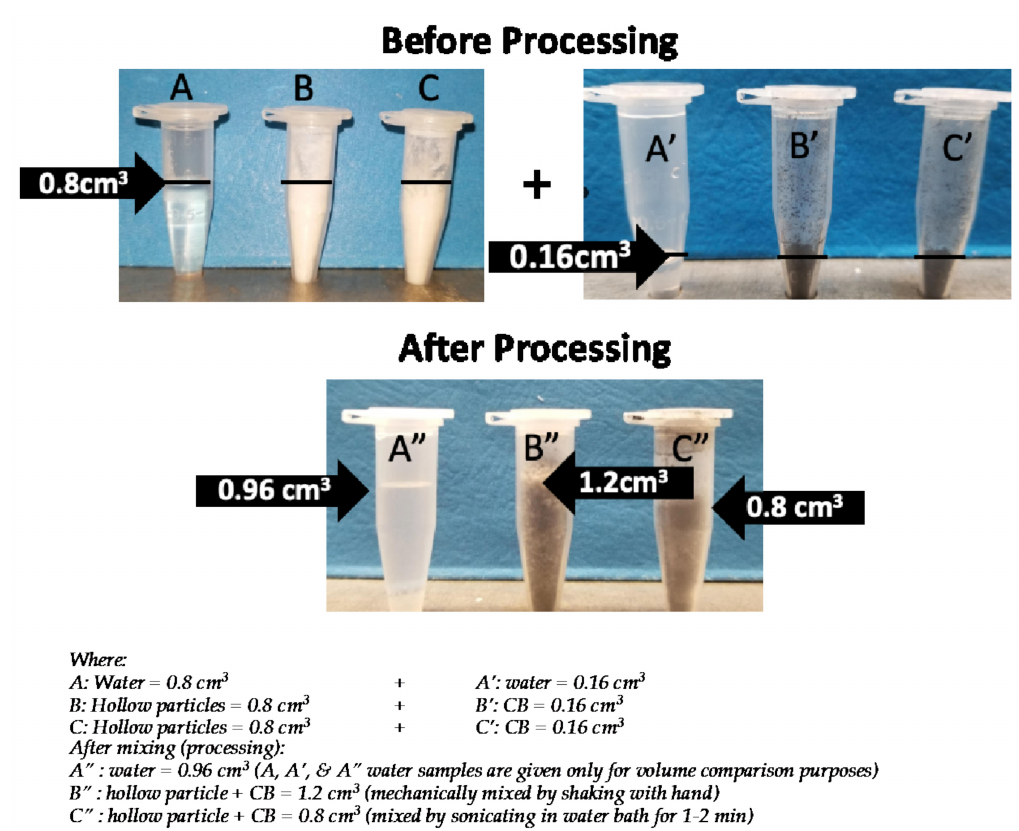
Figure 6. Digital photographs of different samples (hollow particles and carbon black) used in the CB effect on hollow particle thermal conductivity studies. Additionally, amounts of different samples are given in the lower part of the figure.